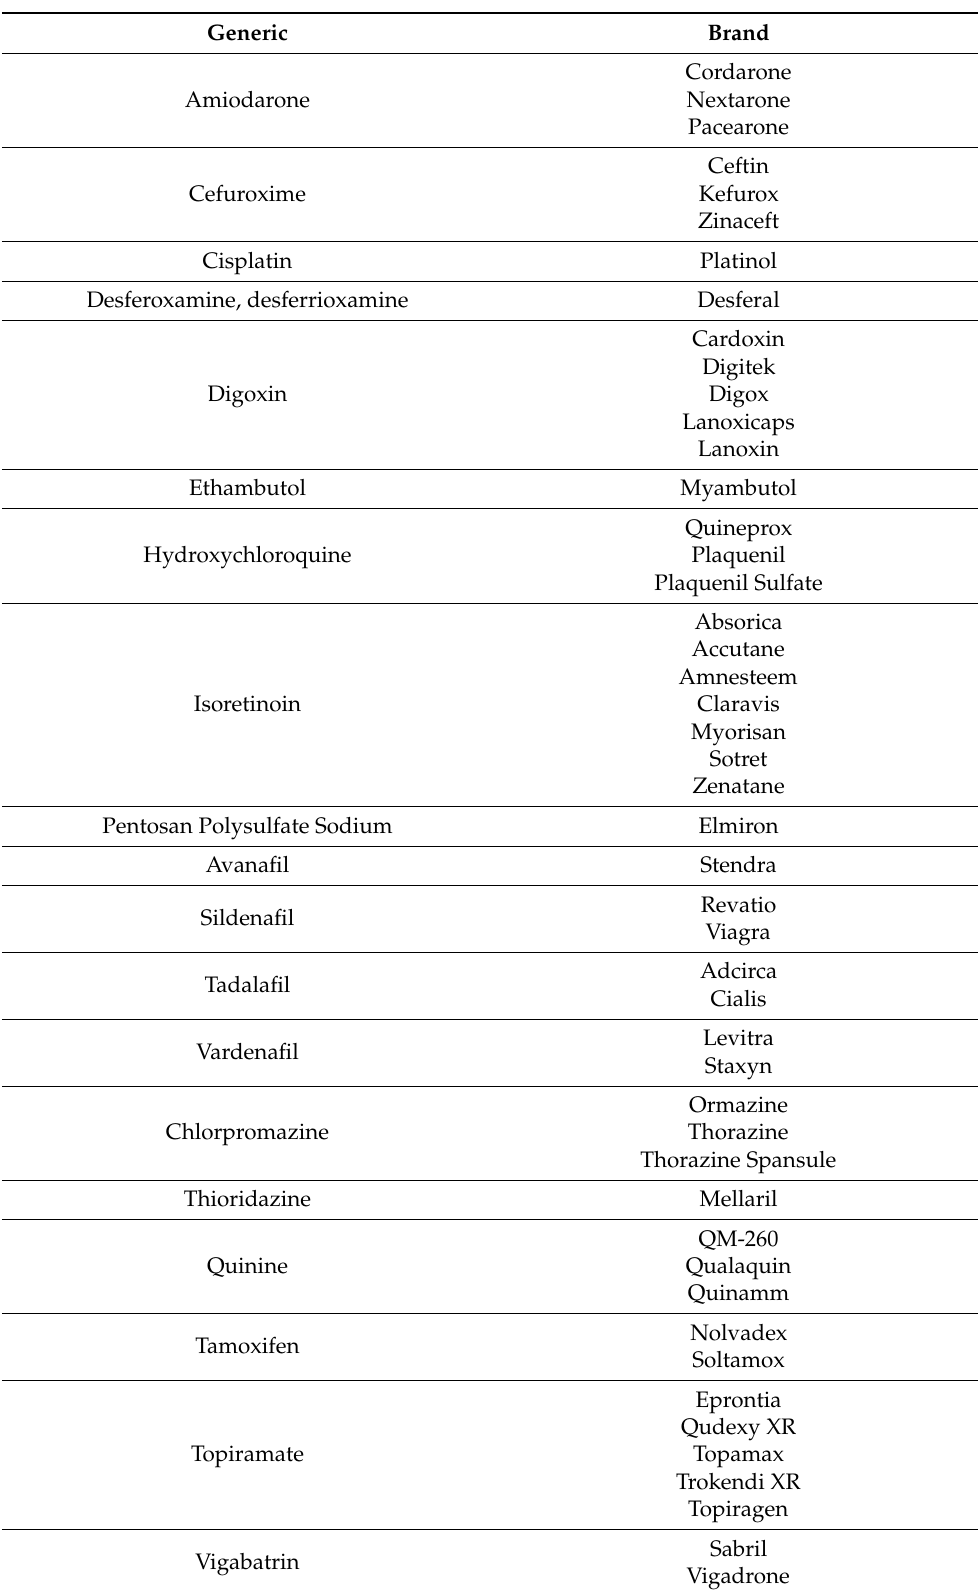
Table 1. Generic vs. brand names for all study